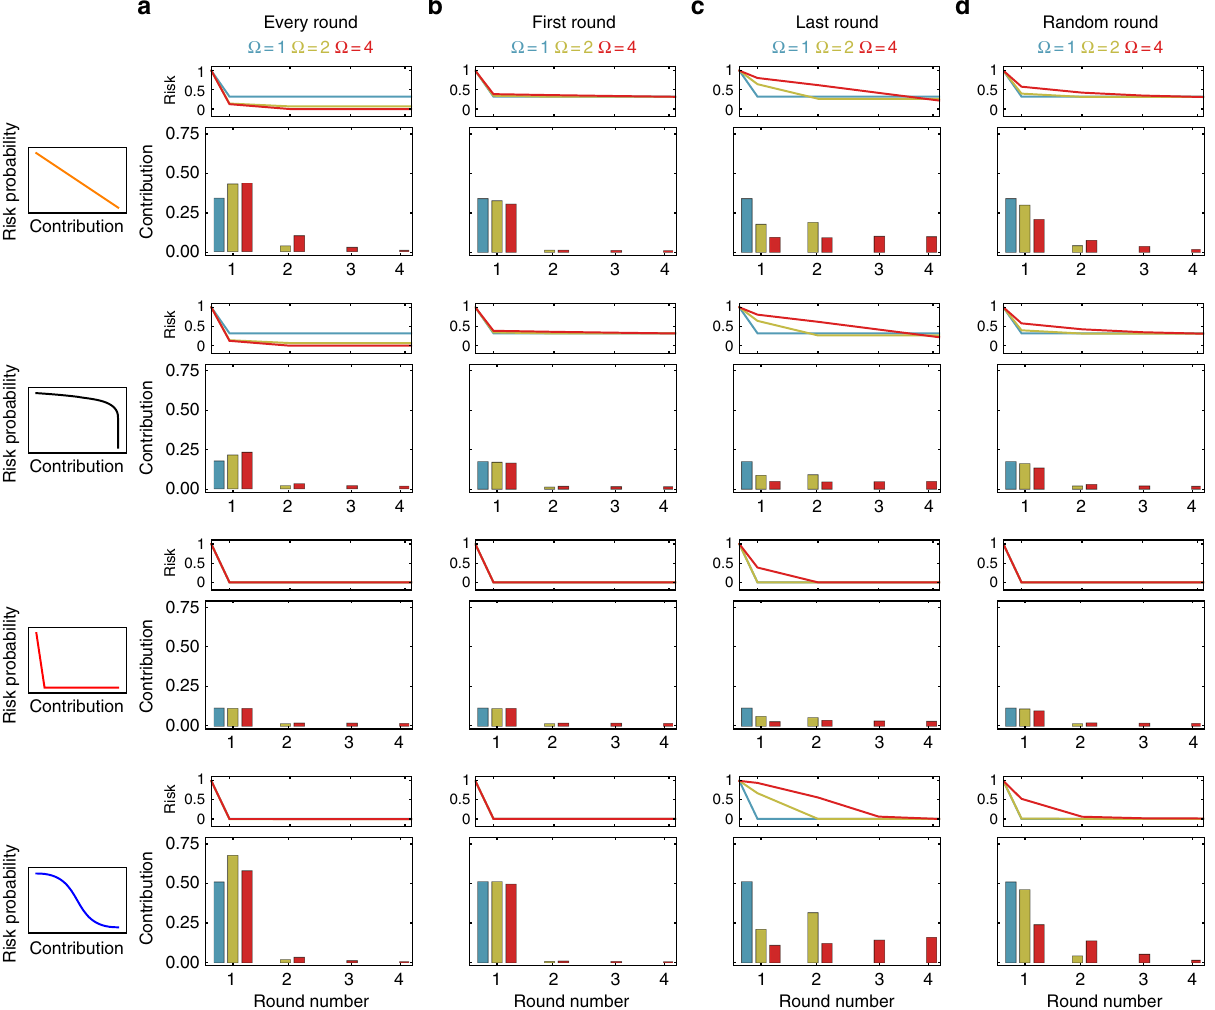
Fig. 2 Contributions for different timings of potential losses in a game with up to four rounds. In a game with Ω rounds, for four different risk curves, we show the average contributions of two players (large panels) and the resulting risk probability (small panels) with a potential loss in a every round, b the fi rst round, c the last round, or d a random round. It is assumed that individuals lose everything, i.e., α = 1 for all individuals. a Multiple losses in the four- round game lead to increased contributions, in particular in the fi rst round. b If the risk is only present in the fi rst round, no further contributions emerge, as expected. c if the risk is only present in the last round 11,20,21 , we recover the wait and see behavior if there is a strong threshold effects, see also Methods. d The scenario where a single event can hit in a random round is qualitatively similar to the last round scenario (games are pair-wise, population size N = 100, 1000 games per generation, mutation rate μ = 0.03, and the standard deviation for mutations in the individual decision thresholds τ r is set to σ =